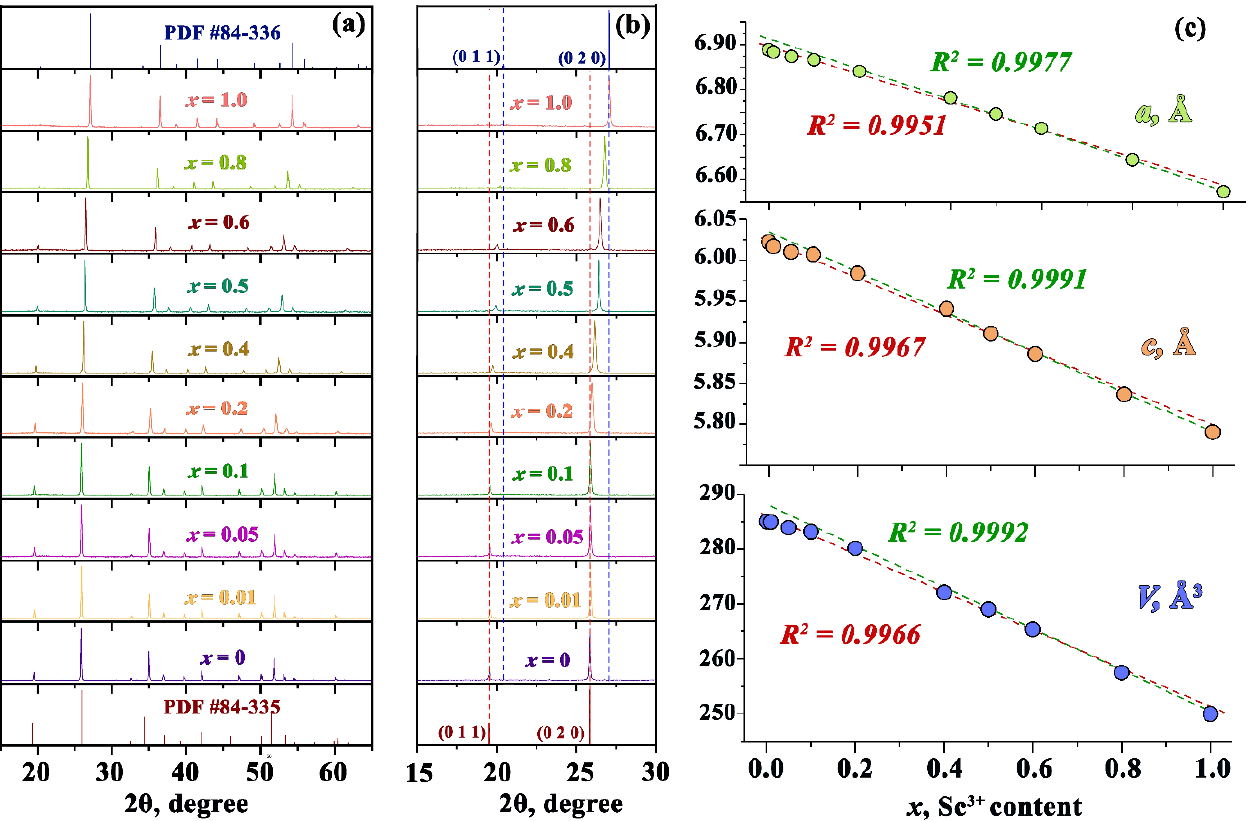
Figure 1. ( a ) PXRD patterns of Y 1 − x Sc x PO 4 ( x = 0, 0.01, 0.05, 0.1, 0.2, 0.4, 0.5, 0.6, 0.8, 1) and Bragg reflections of pure YPO 4 (ICSD 84–335) and ScPO 4 (ICSD 84–336). ( b ) The fragment of PXRD patterns of Y 1 − x Sc x PO 4 ( x = 0, 0.2, 0.4, 0.5, 0.6, 0.8, 1) in the region of selected XRD peak. ( c ) The dependence of the unit cell parameters a ( a ), c ( b ) and volume V ( c ) of the unit cell on Sc content for Y 1 − x Sc x PO 4 . The linear fit is done for the whole range of x values (red dashed curve) and for the x values in the range from 0.1 to 1 (green dashed